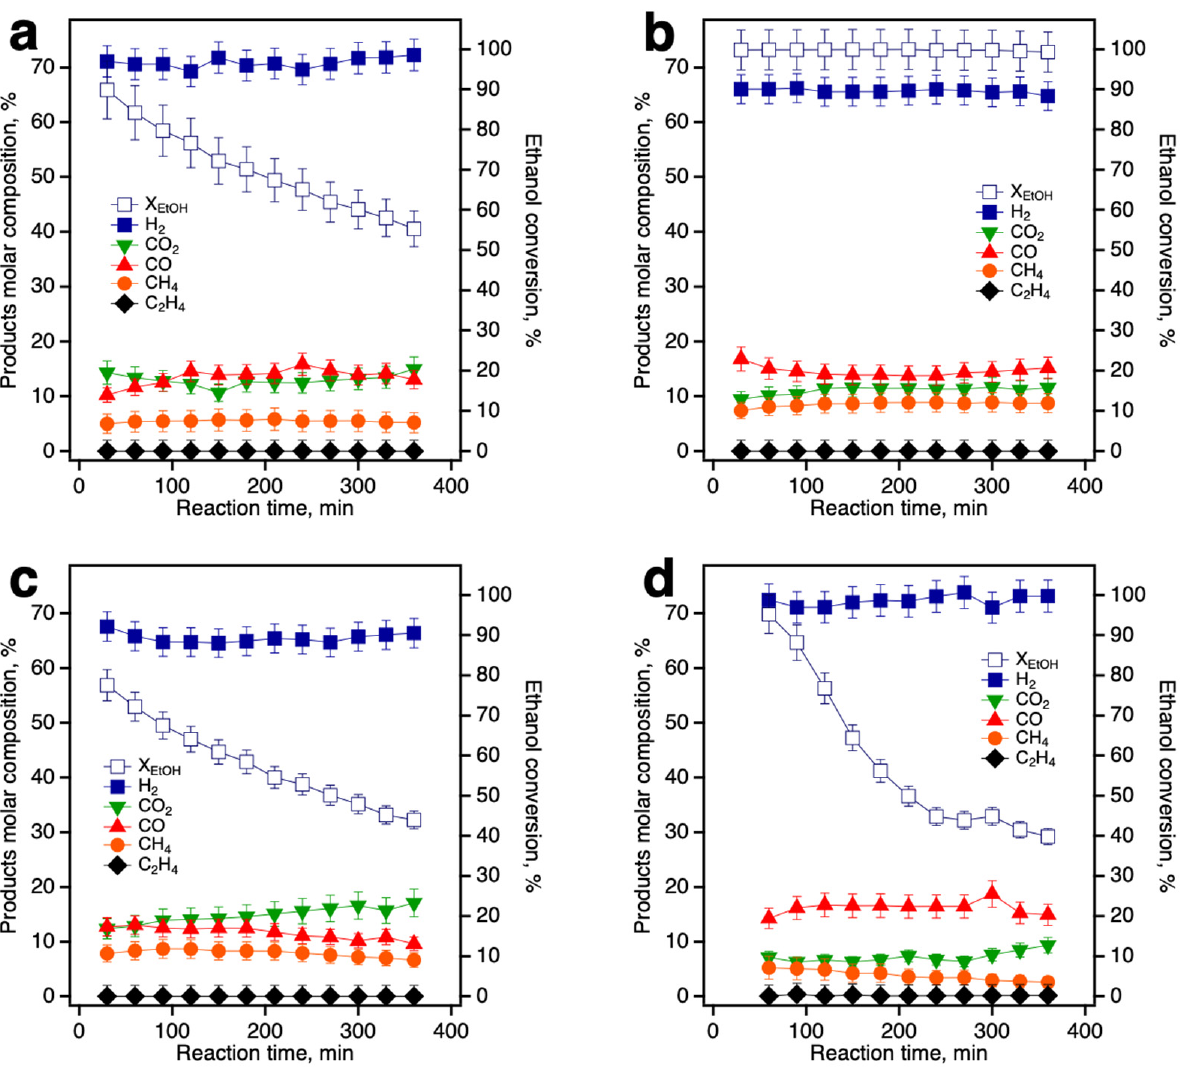
Figure 7. Ethanol conversion (right axis, open markers) and product distribution (left axis, full markers) for Ni/xCe-MCM-41 catalyst in the ethanol steam reforming reaction: ( a ) Ni/MCM-41 at 773 K; ( b ) Ni/0.02Ce-MCM-41_MWUS at 773 K; ( c ) Ni/0.02Ce-MCM-41_MWUS at 723 K; ( d ) Ni/0.02Ce-MCM-41 (Conventional synthesis, no US) at 773 K.